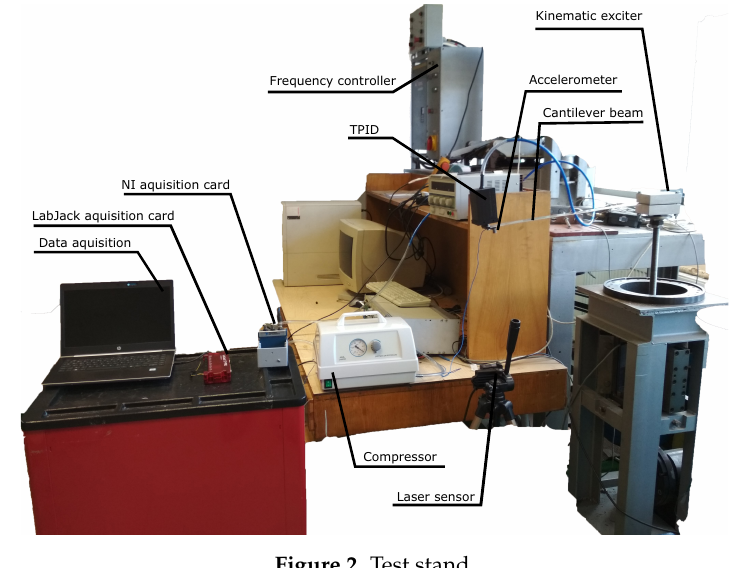
Figure 2. Test stand. Table 1. Parameters used in